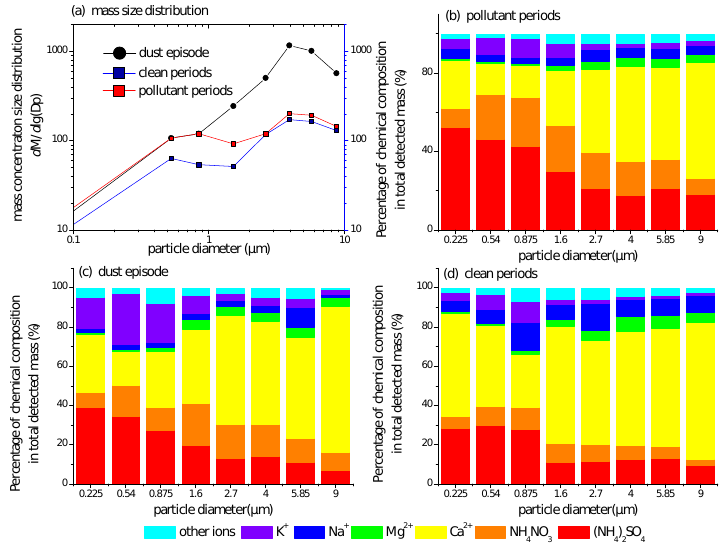
Fig. 3. Aerosol mass size distribution (a) and percentage of chemical compounds in detected water soluble inorganic during clean (b) , dust (c) and pollutant (d) periods. The label diameter in the plot is arithmetic average of aerodynamic diameters. Mass concentration of (NH 4 ) 2 SO 4 and NH 4 NO 3 are derived from equation in reference (Malm et al., 2001).